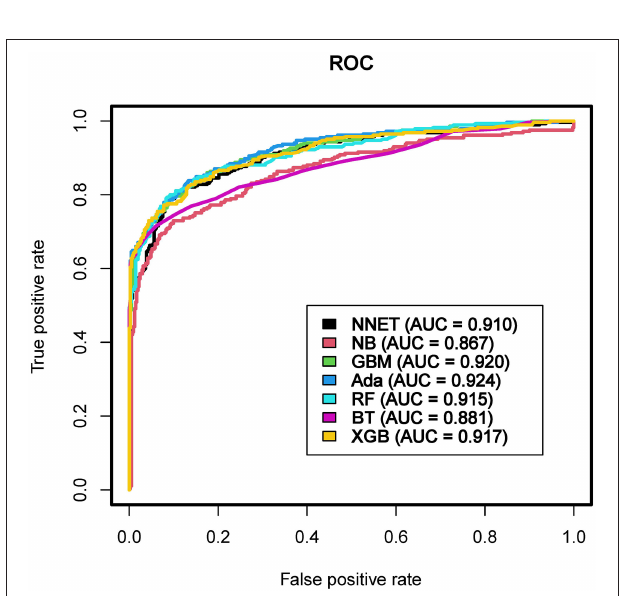
FIGURE 3 | Area under the curve of receiver operating characteristic curve by machine learning models in the validation cohort. ROC, receiver operate characteristics; AUC, area under the curve; NNET, artificial neural network; NB, naïve bayes; GBM, gradient boosting machine; Ada, adapting boosting; RF, random forest; BT, bagged trees; XGB, eXtreme Gradient